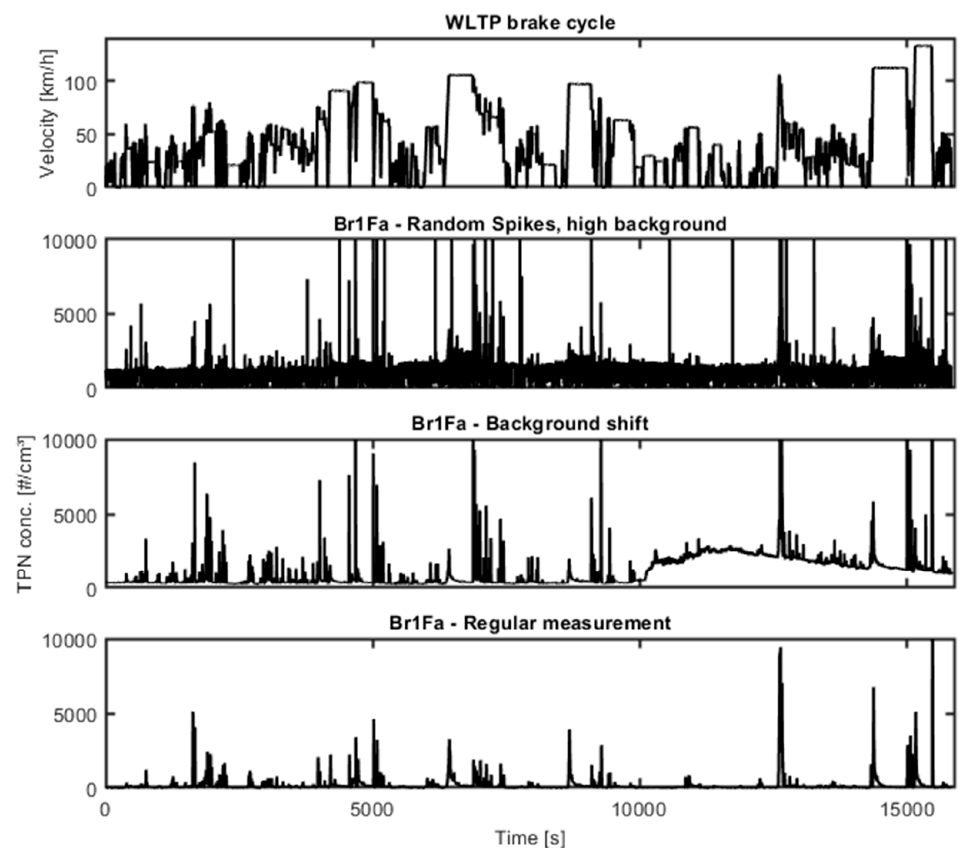
Figure 2. Example for the time-resolved PN emission data for Br1Fa from different labs. Noticeable problems include background concentration in the same order as emission concentrations, random concentration spikes, and shifts in background concentrations.